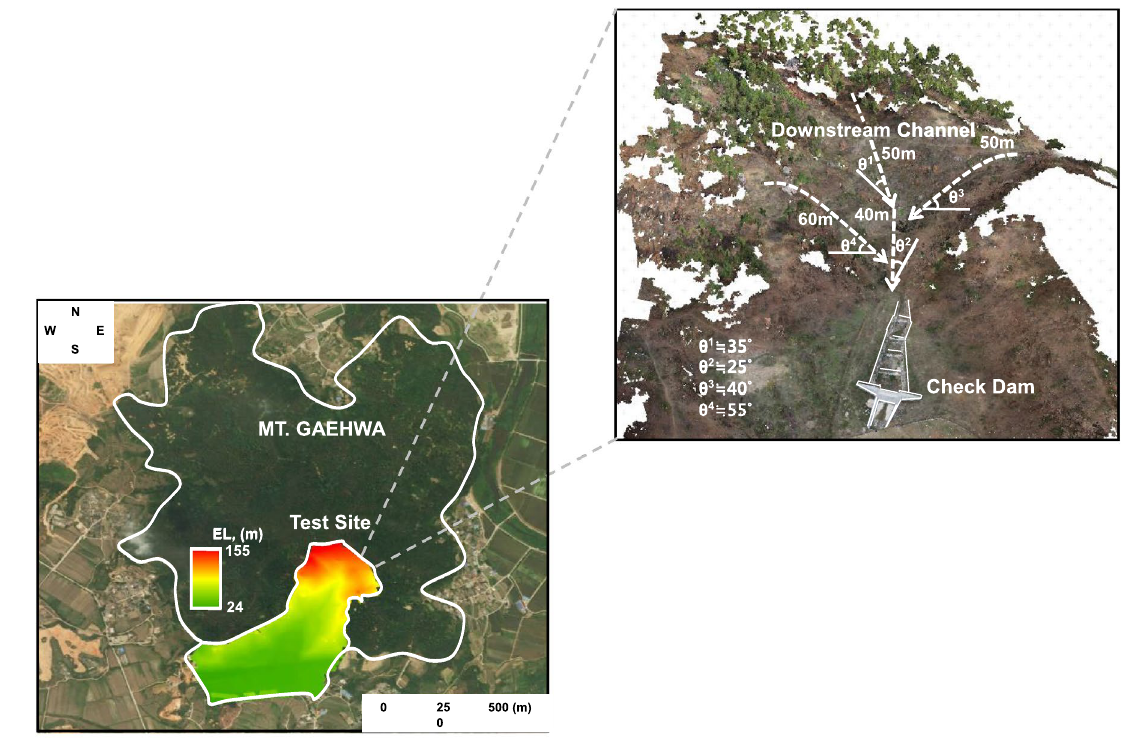
Figure 2. Site description. The picture of left side was captured through https:// map. kakao. com and the detailed topography, placed on right side, was directly obtained by on-site geological survey with UAV survey. The agisoft viewer was applied to find the topography based on measured digital elevation model.